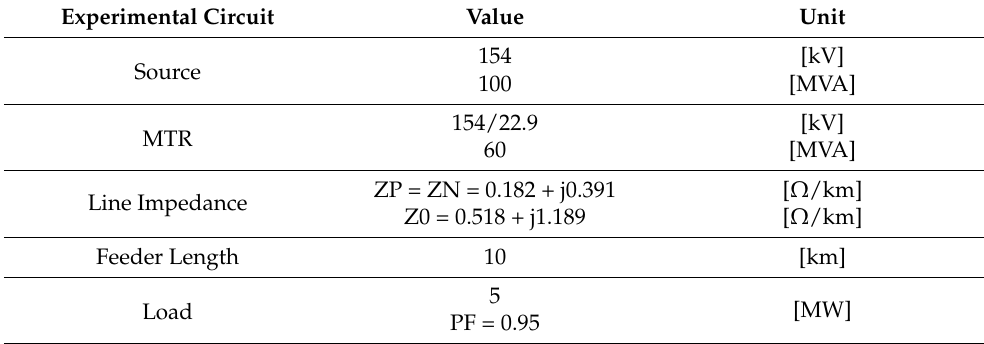
Table 1. Specifications of Power Distribution System.